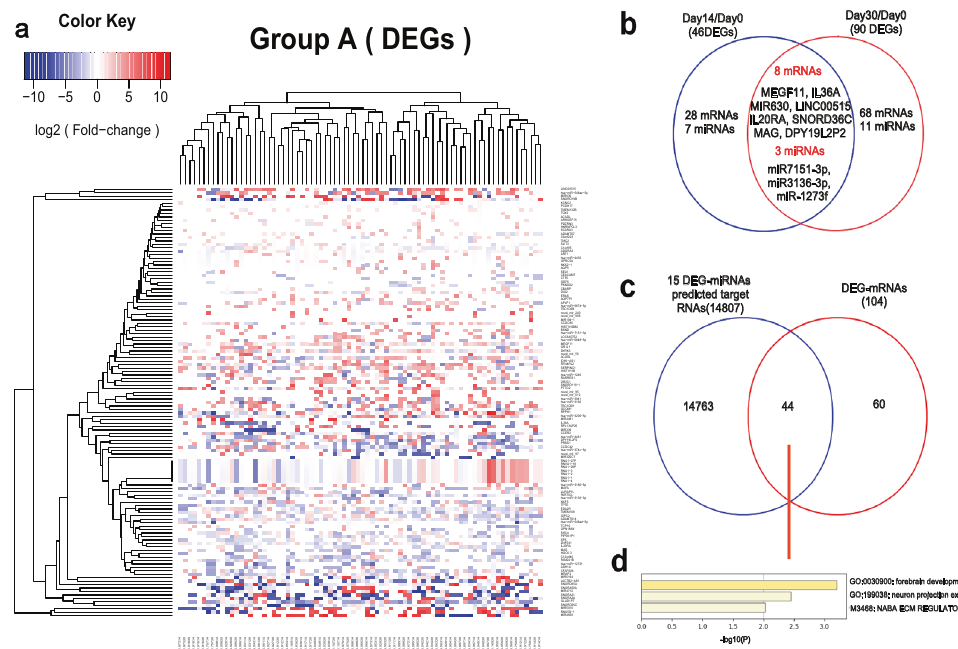
Fig. 4 Differentially express genes targeted by Danhong Injection. a Heatmap of the gene expression pattern (miRNA and mRNA) of the DHI group. Red boxes represent the genes that were upregulated after treatment, while blue ones represent downregulated. b Venn diagram of the numbers of differentially expressed genes (DEGs) before and after treatment. The overlapping area represents the number of genes found to be differentially expressed both at Day 14 or Day 30 after treatment. c Venn diagram of 104 DEG-mRNAs and the predicted target mRNAs of 15 DEG-mRNAs. d The GO biological process categories of the 44 overlapping DEG-mRNAs and the predicted target mRNAs of 15